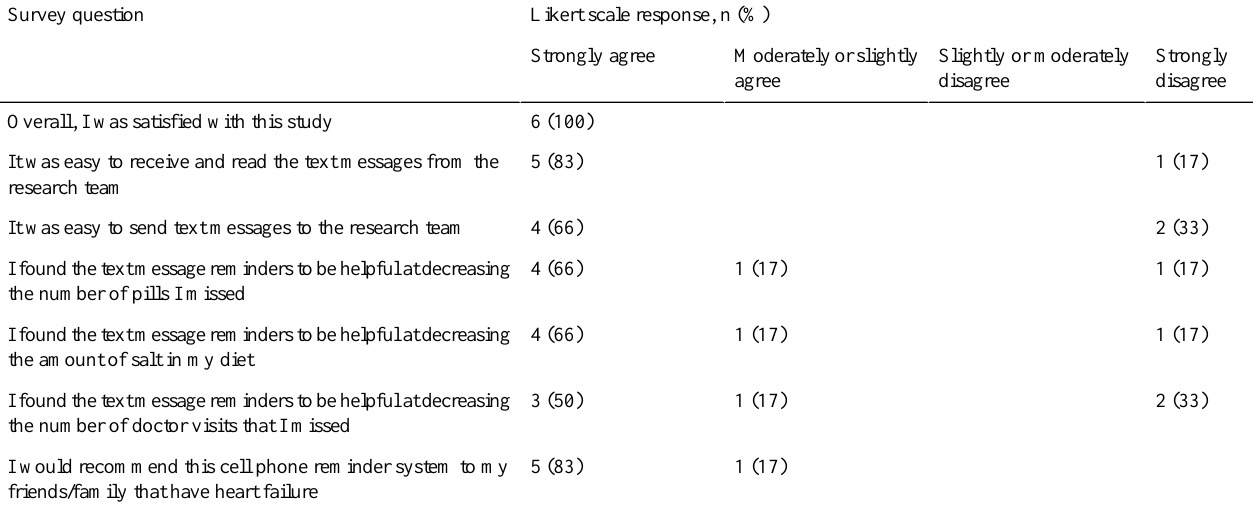
Table 3. Participant evaluation postintervention (n=6).